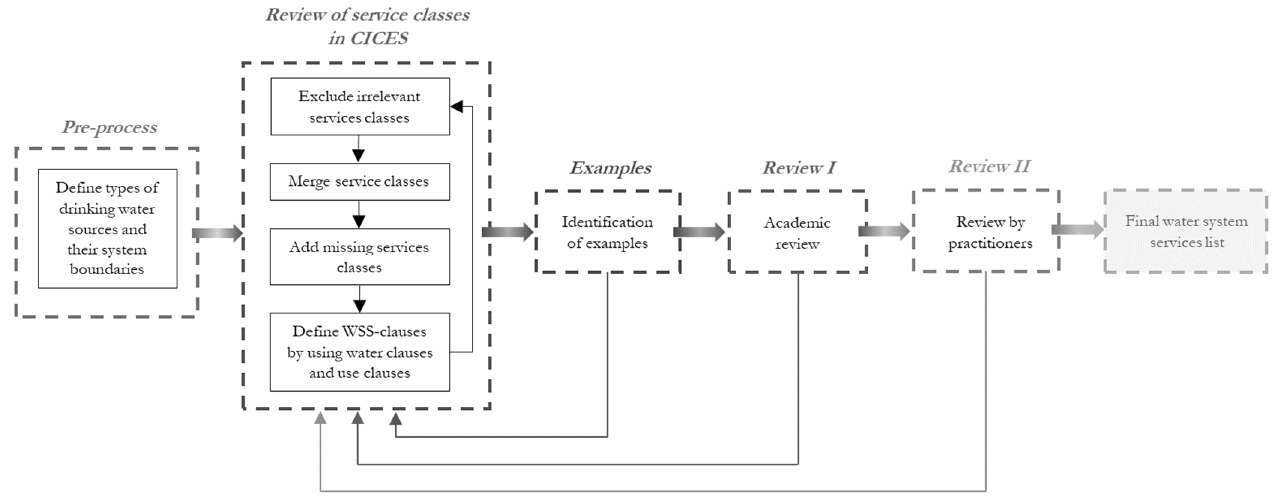
Figure 3. Applied procedure for compiling a list of water system services. The five steps to develop a list of WSS consist of the pre-process (step one), the review of service classes in CICES (step two), the identification of examples (step three), the review by academics (step four), and the review by practitioners (step five). The final output is a list of water system services.